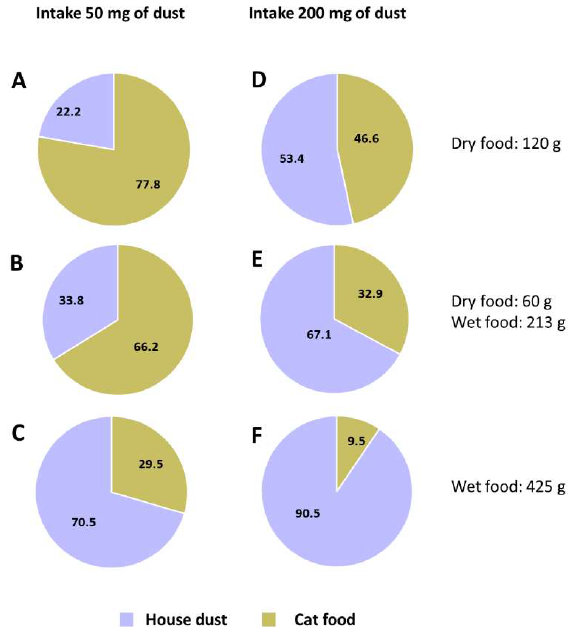
Figure 3. Estimating the contributions of cat food and house dust to PBDE exposure of pet cats in Thailand. These contributions were calculated by assuming a cat with a standard body weight of 4 kg. A pet cat was assumed to ingest dust (50 mg) and consume ( A ) dry food only, ( B ) half dry food and half wet food, or ( C ) wet food only. A pet cat was assumed to ingest dust (200 mg) and consume ( D ) dry food only, ( E ) half dry food and half wet food, and ( F ) wet food only.